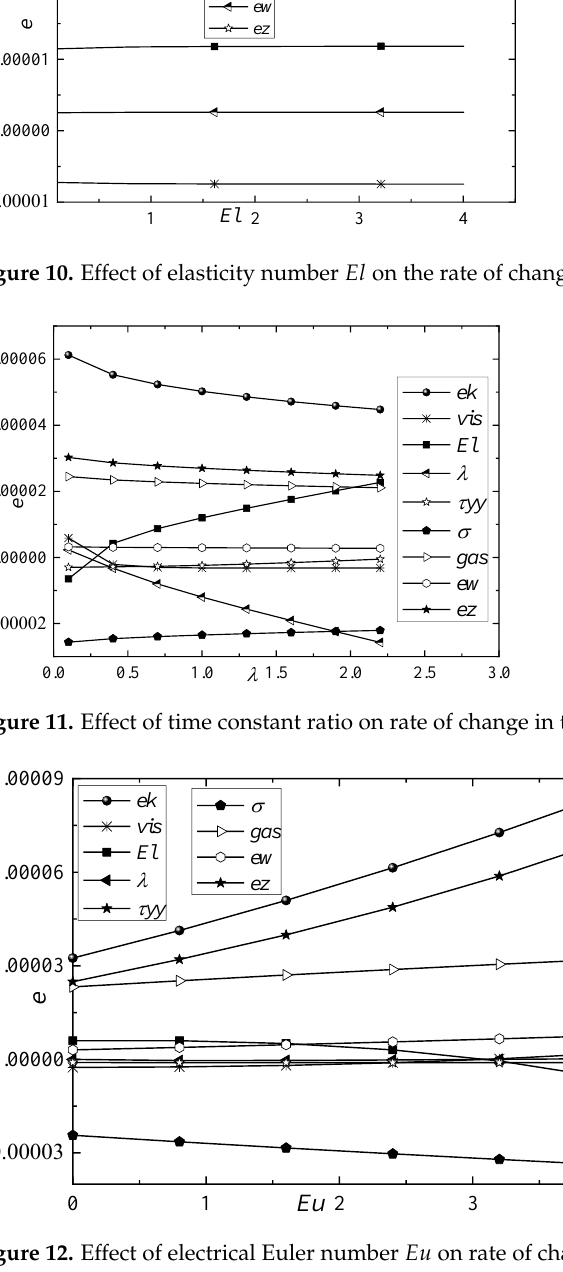
, w w increase El 